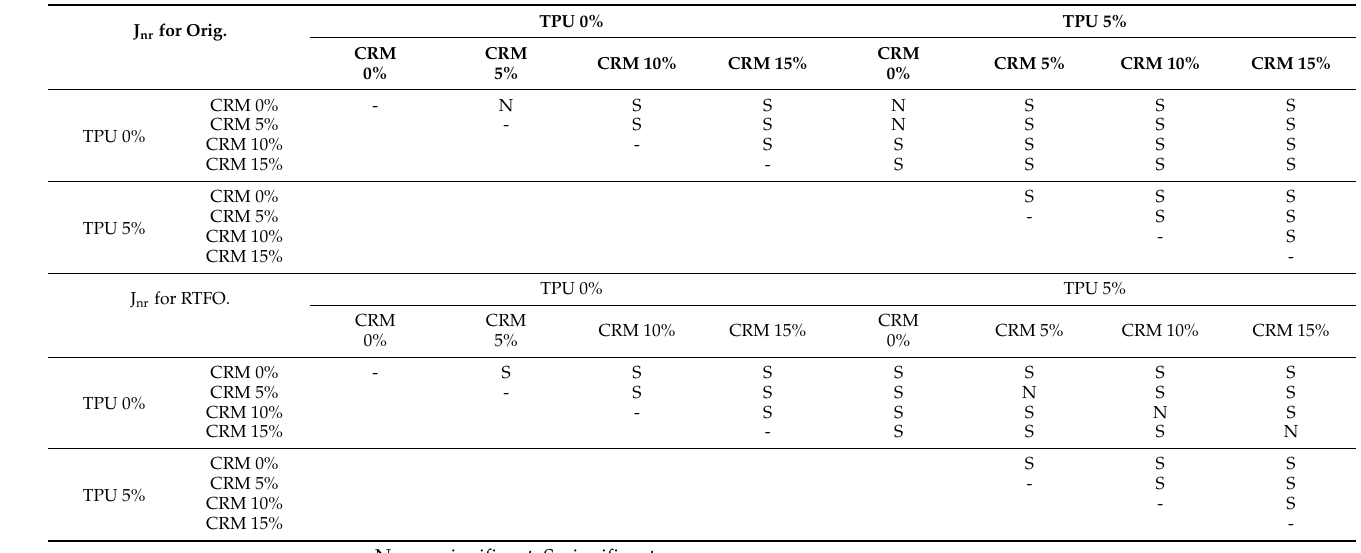
Table 7. Statistical analysis results of the J nr as a function of CRM contents and the addition of TPU ( α = 0.05).